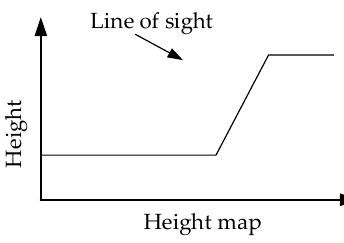
Figure 9. Schematic geometry of the building surface in the height map.